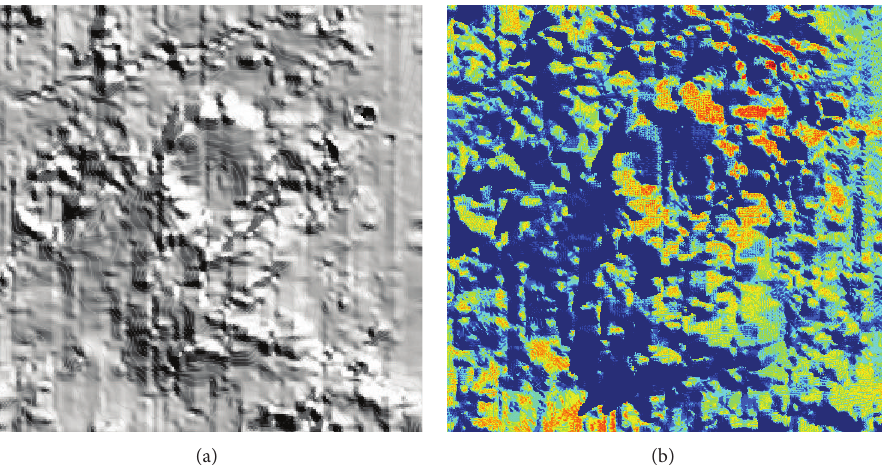
Figure 22: Visualization results of the lunar soil volume. Topography details are enhanced using volumetric ray casting. The result on the right is with shadows and the reflectance of the location based distribution of the minerals.